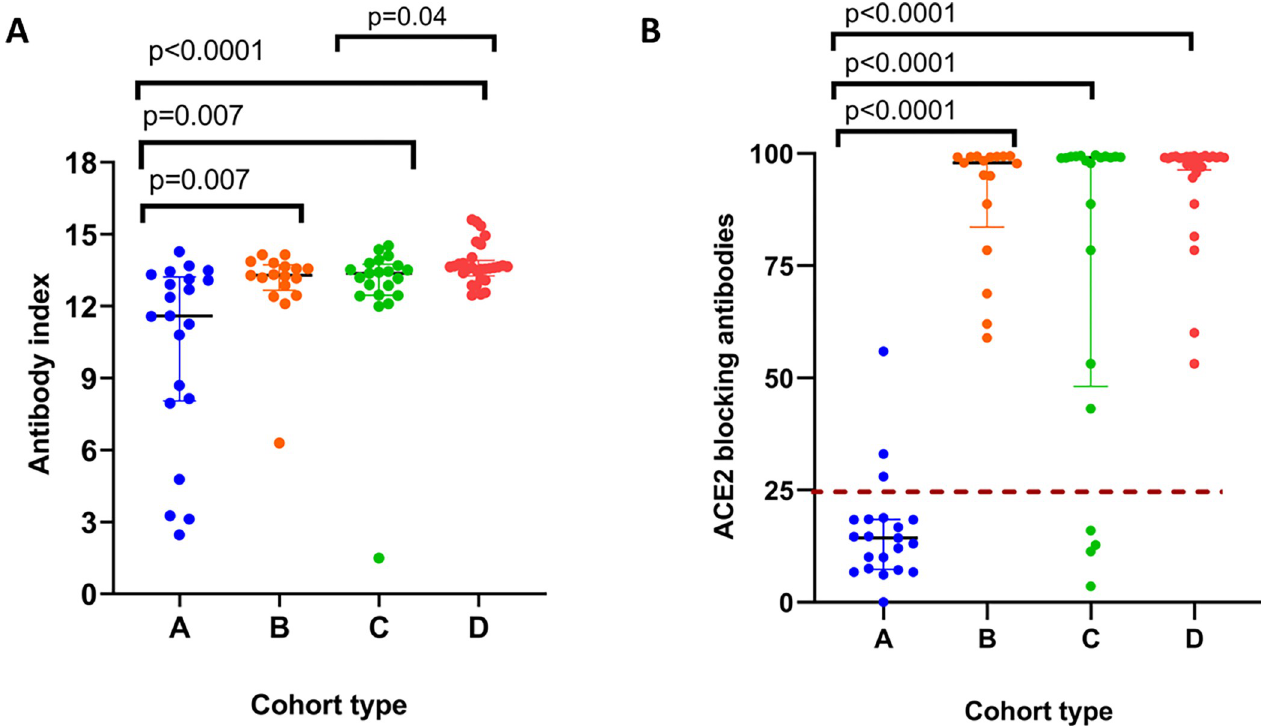
Fig 2. Antibodies to the SARS-COV-2 in Sinopharm/ BBIBP-CorV vaccinees who either received the BNT162b2 booster or were infected. The total antibodies to the RBD (A) or ACE2 blocking antibodies (B) were measured by ELISA in Sinopharm vaccinees at 7 months post second dose, who remained uninfected and un-boosted (cohort A: n = 21), or those who had previous infection and who did not obtain the booster (cohort B: n = 17), or those who were not infected but who received a BNT162b2 booster (cohort C: n = 30) or those who did not receive the booster, but were infected with omicron (cohort D: n = 29). The cut-off value for the positive threshold for the surrogate neutralizing assay, measuring the ACE2 blocking antibodies is indicated in a brown dotted line. The Mann-Whitney test was used to compare the IgG levels between different cohorts. All tests were